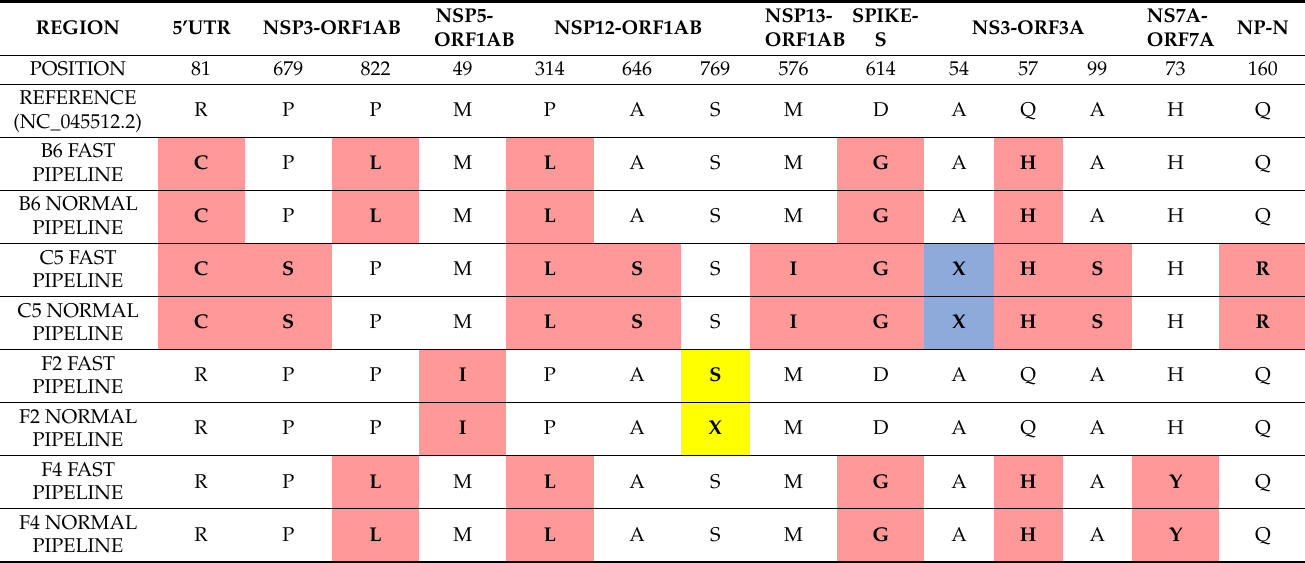
Table 12. Identified Amino Acids Mutations in Batch 1 Samples Running All